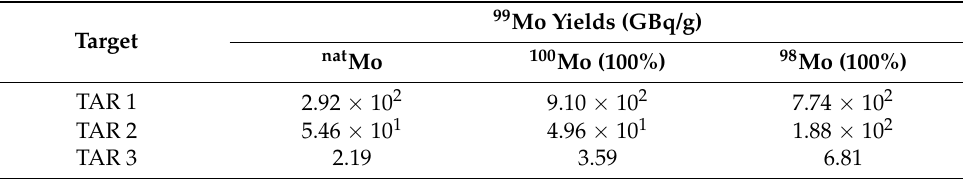
The yields from two highly enriched molybdenum (100% enriched 100 Mo and 100% enriched 98 Mo) were compared with those from natural molybdenum ( 92 Mo 14.84%, 94 Mo Table 6. The yield from 100 Mo target is highest in TAR 1 mainly by (n, 2n) reaction, as this region has the highest fraction of fast neutrons; in TAR 2, the yield from nat Mo is higher than that of 100 Mo, but lower than that of 98 Mo; the yield from 98 Mo is highest in TAR3 mainly by (n, γ ) reaction, where the fraction of thermal neutrons is highest. Table 6. 99 Mo yields with various enrichments of molybdenum isotope at a fusion power of 2.0 GW, 21-day irradiation.